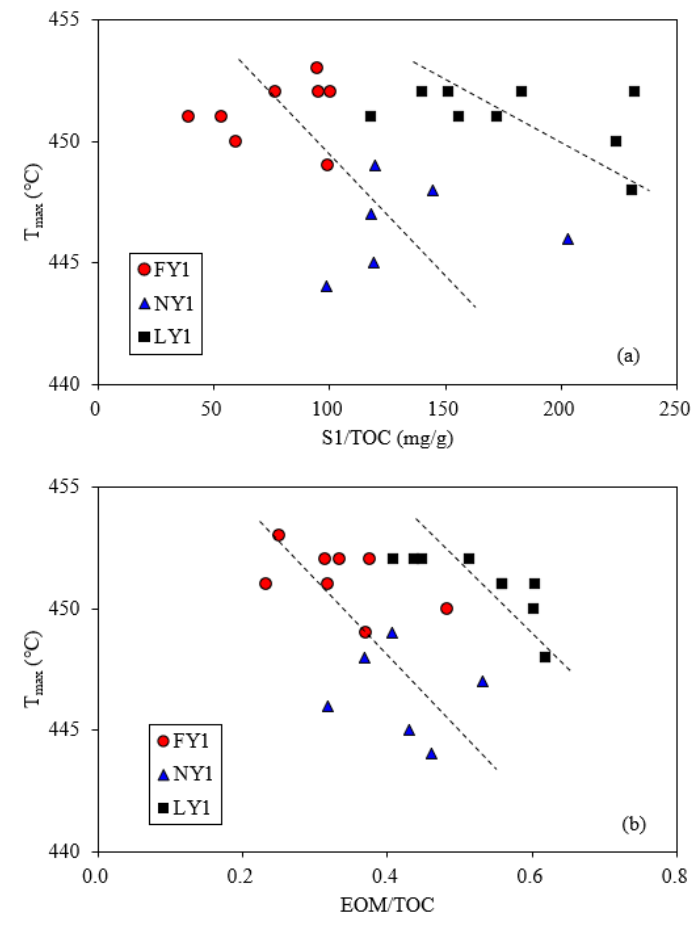
Figure 2. Relationships of T max with S1/TOC ( a ) and EOM/TOC ( b ) for the studied samples.